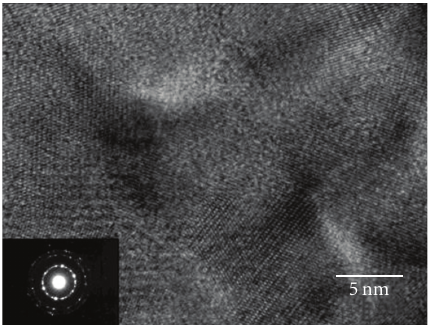
Figure 1: TEM image and ED pattern for a boron-doped nanocrys- talline diamond thin